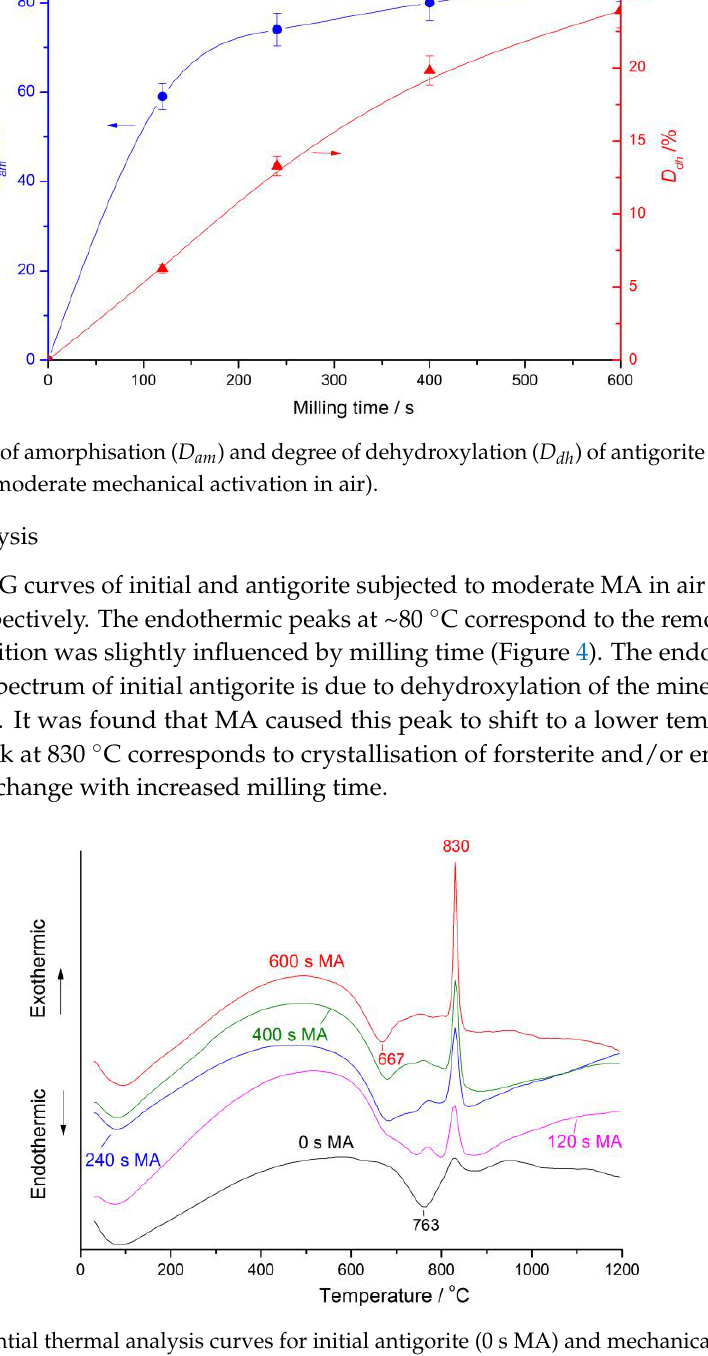
Figure 4. Differential thermal analysis curves for initial antigorite (0 s MA) and mechanically-activated (MA) antigorite (moderate mechanical activation in air).